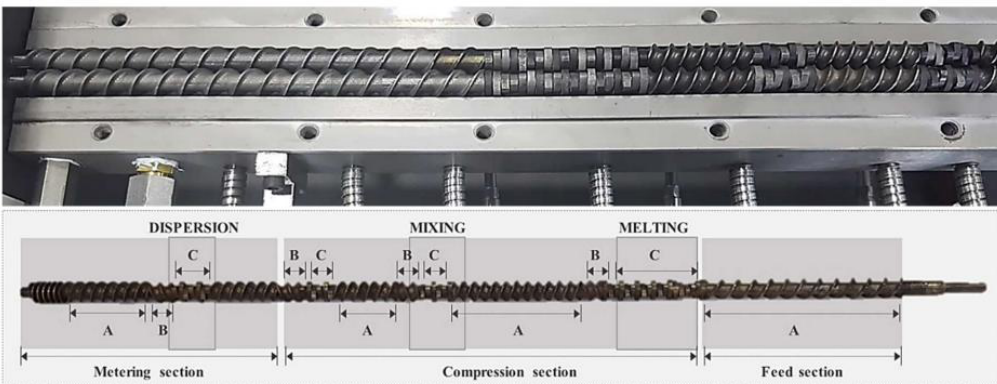
Figure 3. The configuration of co-rotating intermeshing twin-screw (A = Forward conveying screw elements, B = Reverse conveying screw elements, C = Kneading screw